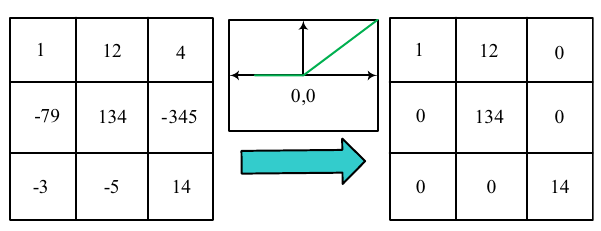
Figure 3: ReLU activation function operation